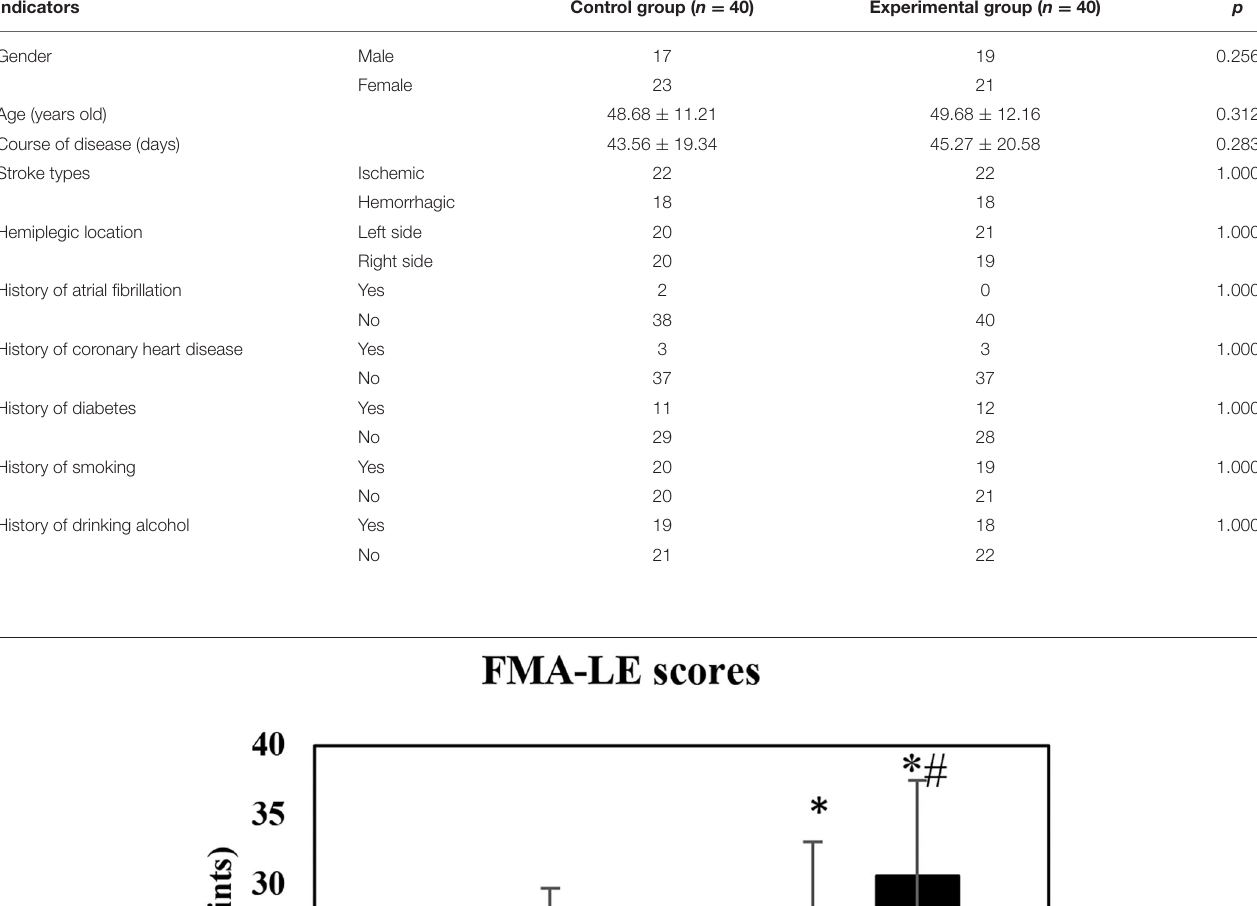
TABLE 1 | Comparison of patients’ baseline data in the two groups. Indicators